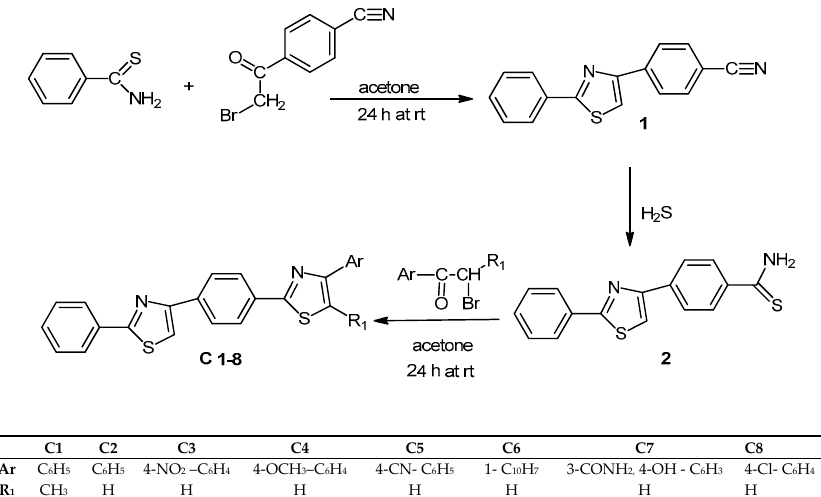
Figure 2. The synthesis of the 2-phenylthiazole derivatives ( C1 – 8 ).